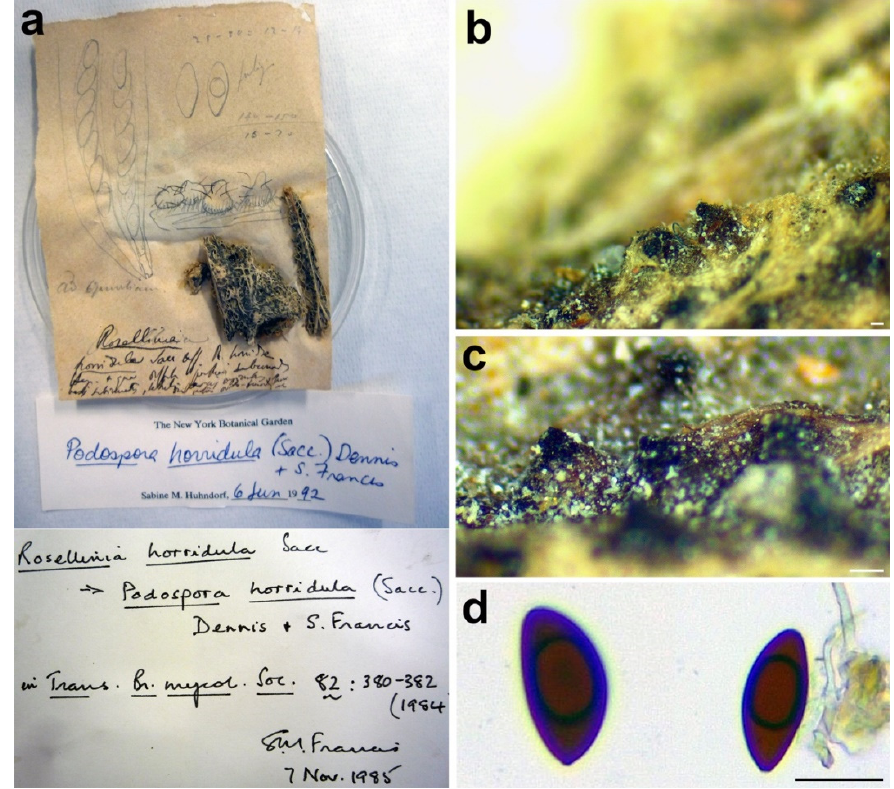
Figure 9. Rosellinia horridula . ( a ) Original fungarium specimen. ( b , c ) Perithecia on natural substrate. ( d ) Ascospores. Scale bars: ( b , c ) = 100 μ m; ( d ) = 20 μ m.